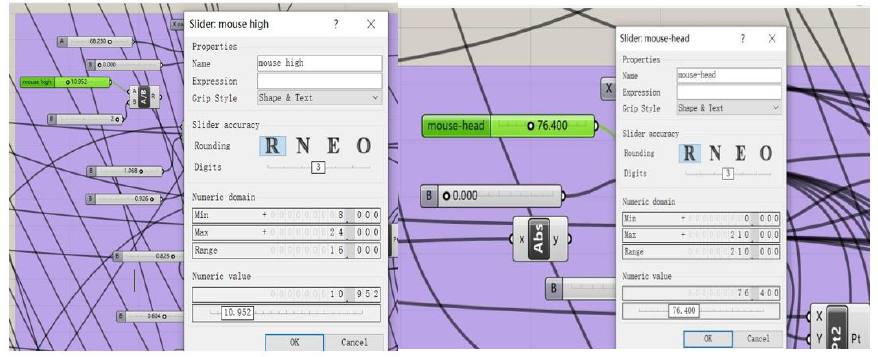
Figure 14. Parameter setting.